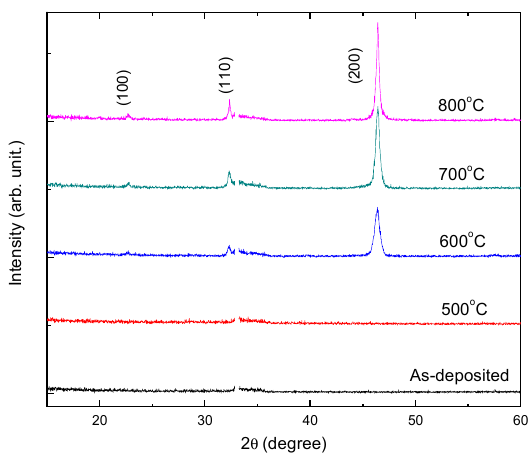
Figure 1. X-ray diffraction (XRD) patterns of SrTiO 3 thin film annealed at different temperatures.